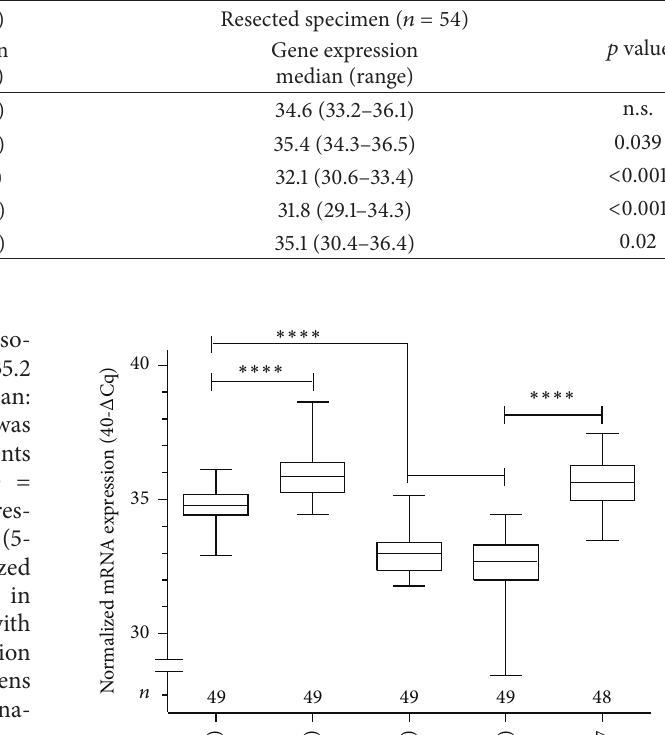
R E ( R F G E Figure 2: Distribution of mRNA expression values in analyzed biopsies. Normalized mRNA expression values (40- Δ Cq) of RT- qPCR evaluated HER (ERBB) family marker genes and MKI67 are presented. Lowest expression levels were observed for ERBB3 and ERBB4 and highest expression for ERBB2 and MKI67 (box and whiskers plots ranging from minimum to maximum). Gene expression values were compared by two-way Mann-Whitney test ( ∗∗∗∗ 𝑝 < 0.0001